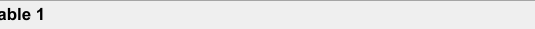
Table 1 Classification of categories of causes and causes analysed for trends of PYLL. Causes and clusters of causes